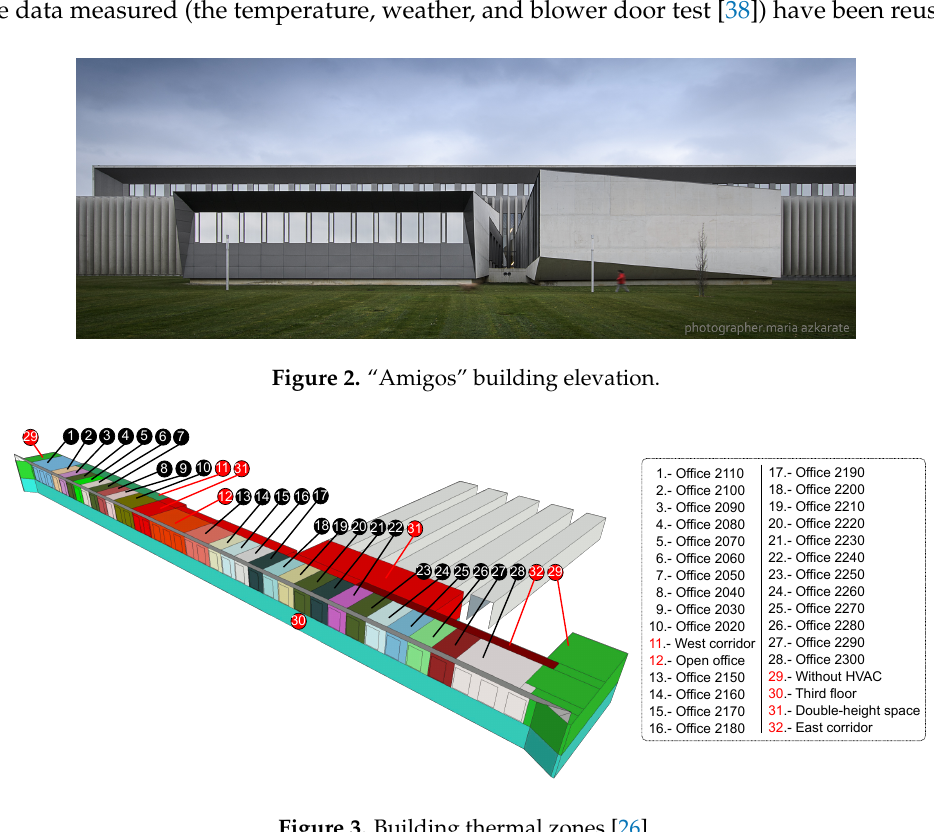
Figure 3. Building thermal zones